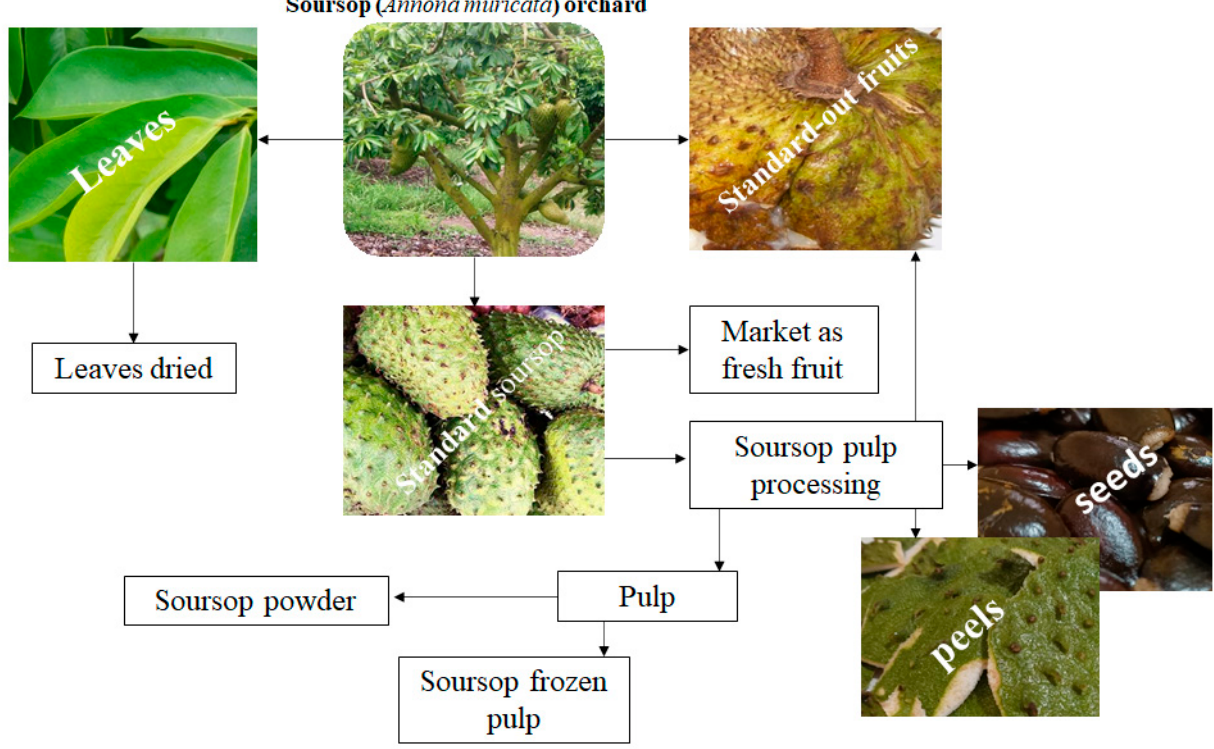
Figure 1. General scenario of waste generation in the soursop production chain.